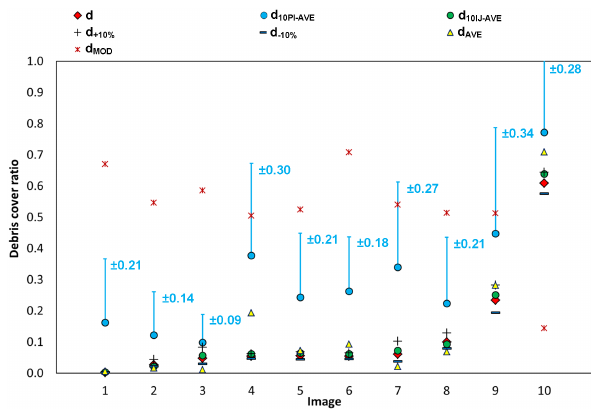
Figure 9. Values of debris cover ratio from analyzing 10 randomly selected images (shown in Fig.